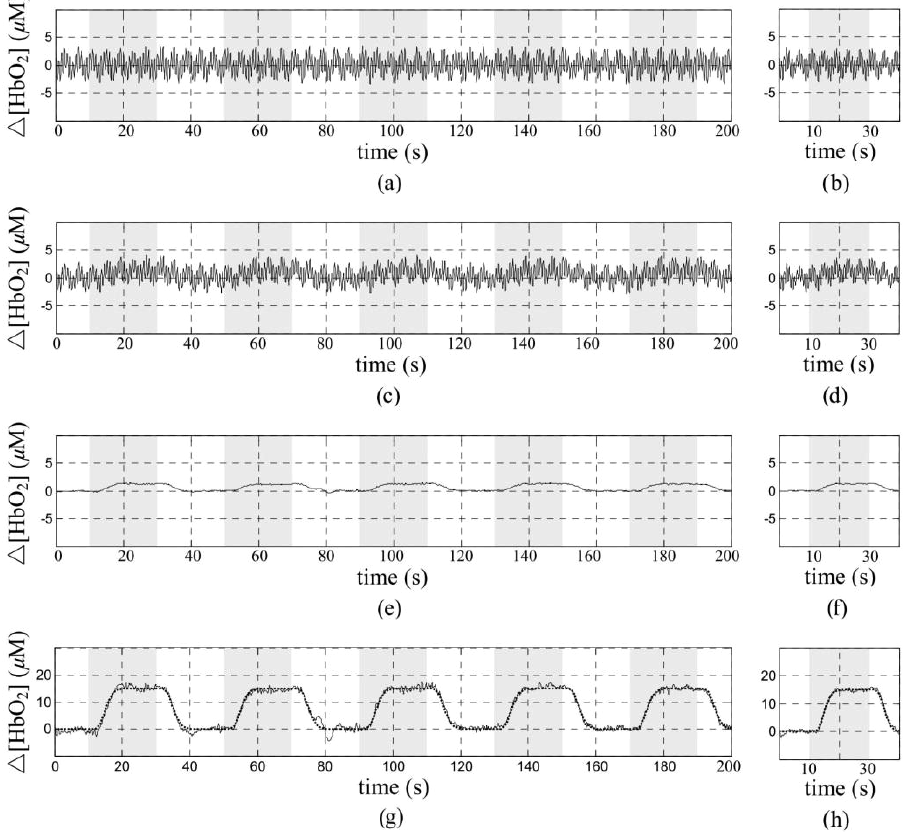
Fig. 4. Concentration changes of HbO 2 extracted with Figs. 4(g) and 4(h), as well as Figs. 5(g) and 5(h).